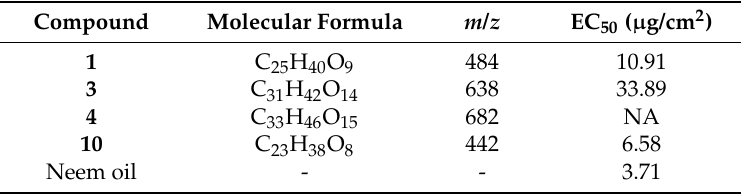
Table 2. Antifeedant activity of compounds 1 , 3 , 4 , and 10 against Spodoptera exigua. Compound